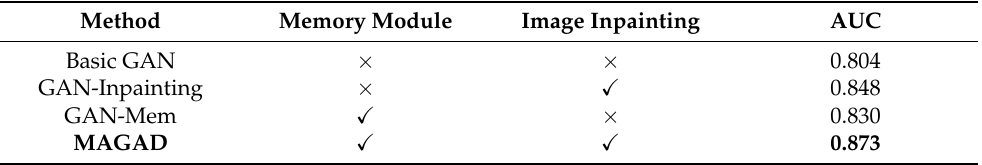
Table 4. Ablation studies on different components of our